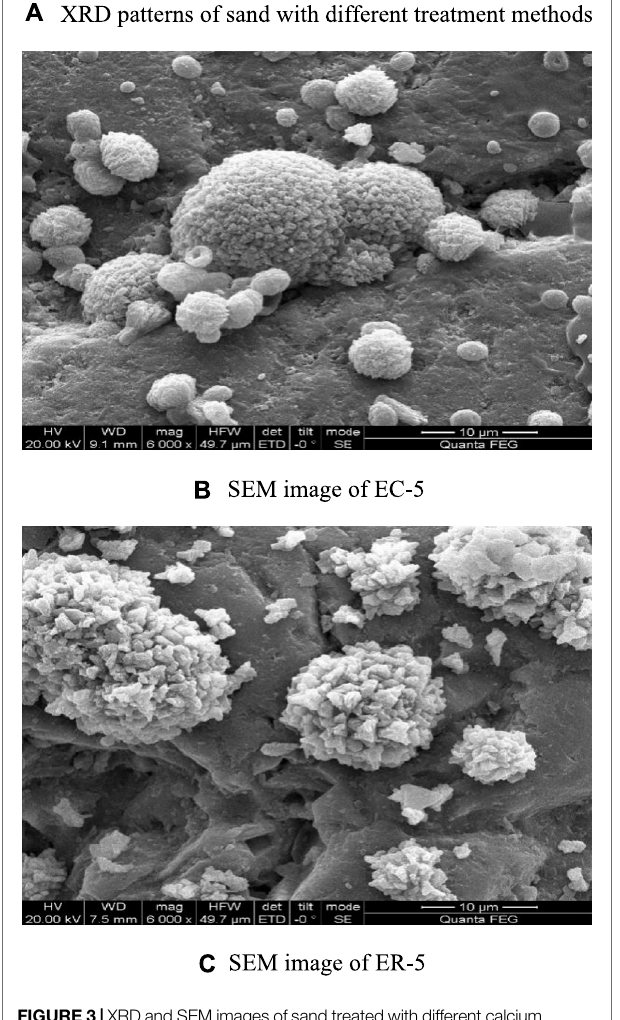
Frontiers in Physics |